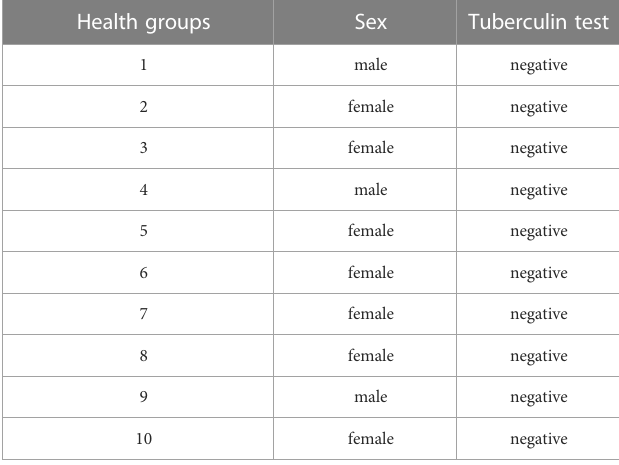
TABLE 1 Basic information for 10 healthy